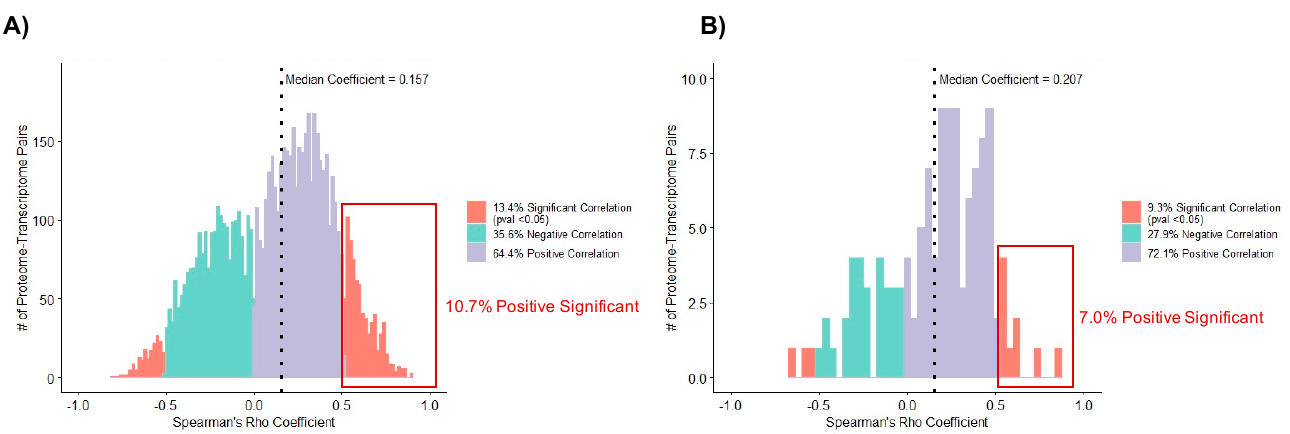
Figure 6. Spearman’s Rho analysis within-gene pairwise correlation of proteins to observed transcripts in matched patient leukemic samples. Teal, negative correlation; Purple, positive correlation; Orange, significant correlation (Spearman’s Rho p -value < 0.05) with either negative or positive correlation coefficient; Red Box, positive significant correlation. ( A ) Global correlation bar plot of available 7039 protein–gene pairs and ( B ) Correlation bar plot of 129 significant DEPs from our 3 comparative analysis with gene pairs.